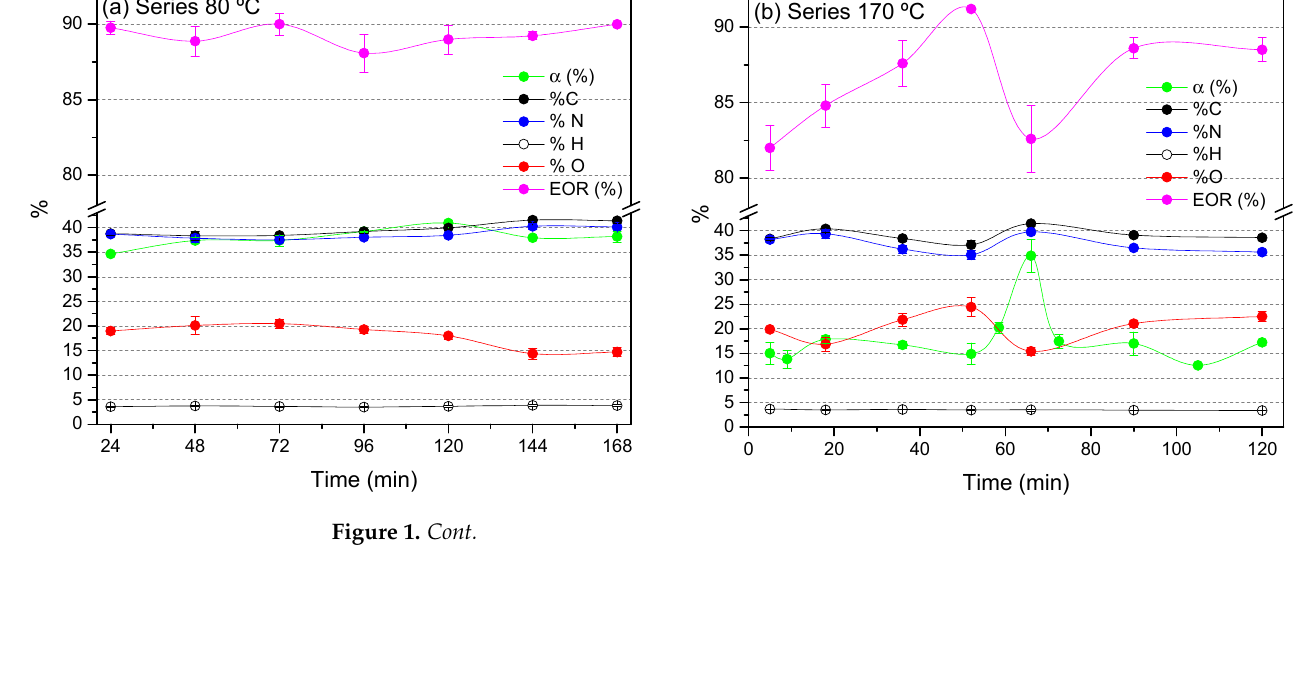
Figure 1. Evolution of NH 4 CN polymerization over the reaction time. ( a ) Series 80 °C is shown as repre- sentative control experiments for cyanide polymerization using CTH; and ( b ) series 170 °C, ( c ) series 190 °C and ( d ) series 205 °C of cyanide polymerizations assisted by MWR. Green lines = conversion degree, α (%), where α (%) = [(initial mg of CN − )/(final mg of insoluble polymer)] × 100 (for details, please see Table S1); black lines = % C; blue lines = % N; red lines = % O; pink lines = extension of the reaction, EOR (%), where EOR (%) = [I 1640 /(I 2200 + I 1640 )] × 100, calculated from the intensity of the respective features of the FTIR spectra (for details of elemental analysis data and EOR values, please see Table S2). At least three inde- pendent experiments were considered for each point reported, i.e., at least three independent samples were measured. The average values together with their corresponding standard deviations are presented. With respect to the evolution of the chemical compositions of the cyanide polymers, in the 80 °C series, we observed that the % C (black line) is slightly increasing and the % O is decreasing (red line) with the reaction time (Figure 1a). However, this clear and al- most lineal behavior observed for the reactions at 80 °C is not all appreciated in the pro- gress of the elemental composition of the polymers synthesized at higher temperatures (Figure 1b–d). However, a detailed representation of the C/N molar relationships (Figure 2a) strongly indicates that the longer reaction times and the higher temperature leads to the generation of macromolecular systems poorer in nitrogen than shorter reaction times at the lower temperature. Thus, the polymers produced at 205 °C are the poorest in nitro- gen (Figure 2a). This fact might be related to deamination processes during cyanide polymerization, which might be favored at high temperature, leading to the generation of N-heterocycles, as proposed previously [6]. On the contrary, the curves showing C/O,